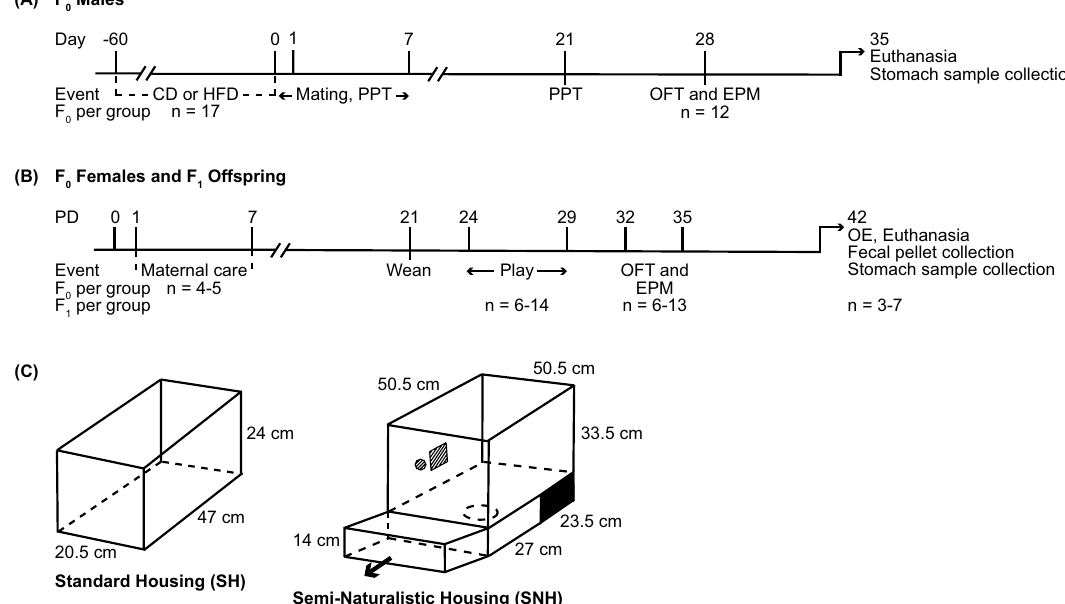
Figure 1. Experimental timelines and schematic representations of the housing conditions used for standard housing (SH) and semi-naturalistic housing (SNH). ( A ) Timeline of treatment procedures involving F 0 males. Males were fed either control diet (CD) or high-fat diet (HFD) for 60 days prior to a partner preference test (PPT) using sexually receptive, naïve females. Within 12 h of the PPT, males were bred with different receptive naïve females. Following mating, males were removed and F 0 females were left undisturbed until postnatal day (PD) 0. After mating, F 0 males were maintained on standard chow for 21 days before a second PPT. One week after the second PPT, F 0 male anxiety-like defensive behavioral responses were assessed in the open-field test (OFT) and the elevated plus-maze (EPM). Following behavioral testing, F 0 males were immediately sacrificed; stomachs were collected, frozen and stored at − 80 °C for microbiome processing. ( B ) Timeline of treatment procedures for F 0 females and the F 1 offspring. After birth (postnatal day 0, PD0), offspring were counted, sexed, and weighed before being transferred to either fresh standard housing (SH) or semi-naturalistic housing (SNH), with biological mothers, until weaning. Maternal behavior (Maternal care) was scored for observational periods of 72 min, five times per day for seven consecutive days. At PD21, all offspring were weighed, weaned and placed in SH with a same-sex littermate. Play behavior was recorded in the home cage from PD24–29, followed by testing in the OFT and EPM on PD32 and 35, respectively. Predator odor exposure (OE) testing took place on PD42 with male and female offspring exposed to either a control odor (CO) or predator odor (PO) for 30 min, followed immediately by sacrifice. Fecal pellets and stomachs were collected, frozen and stored at − 80 °C for microbiome processing. Sample sizes are provided in the figure for both F 0 and F 1 groups. ( C ) Schematics of the SH and SNH. The SNH consisted of a lower burrow compartment contained within a drawer that could be moved out to facilitate cage cleaning and an upper section that contained food and water; the two sections were connected by a hole (visible in the upper section). CD control diet, CO control odor, EPM elevated plus-maze, HFD high-fat diet, OE odor exposure, OFT open-field test, PD postnatal day, PO predator odor, PPT partner preference test, SH standard housing, SNH semi-naturalistic housing. Adapted from Korgan et al. 11 , with permission (License Number